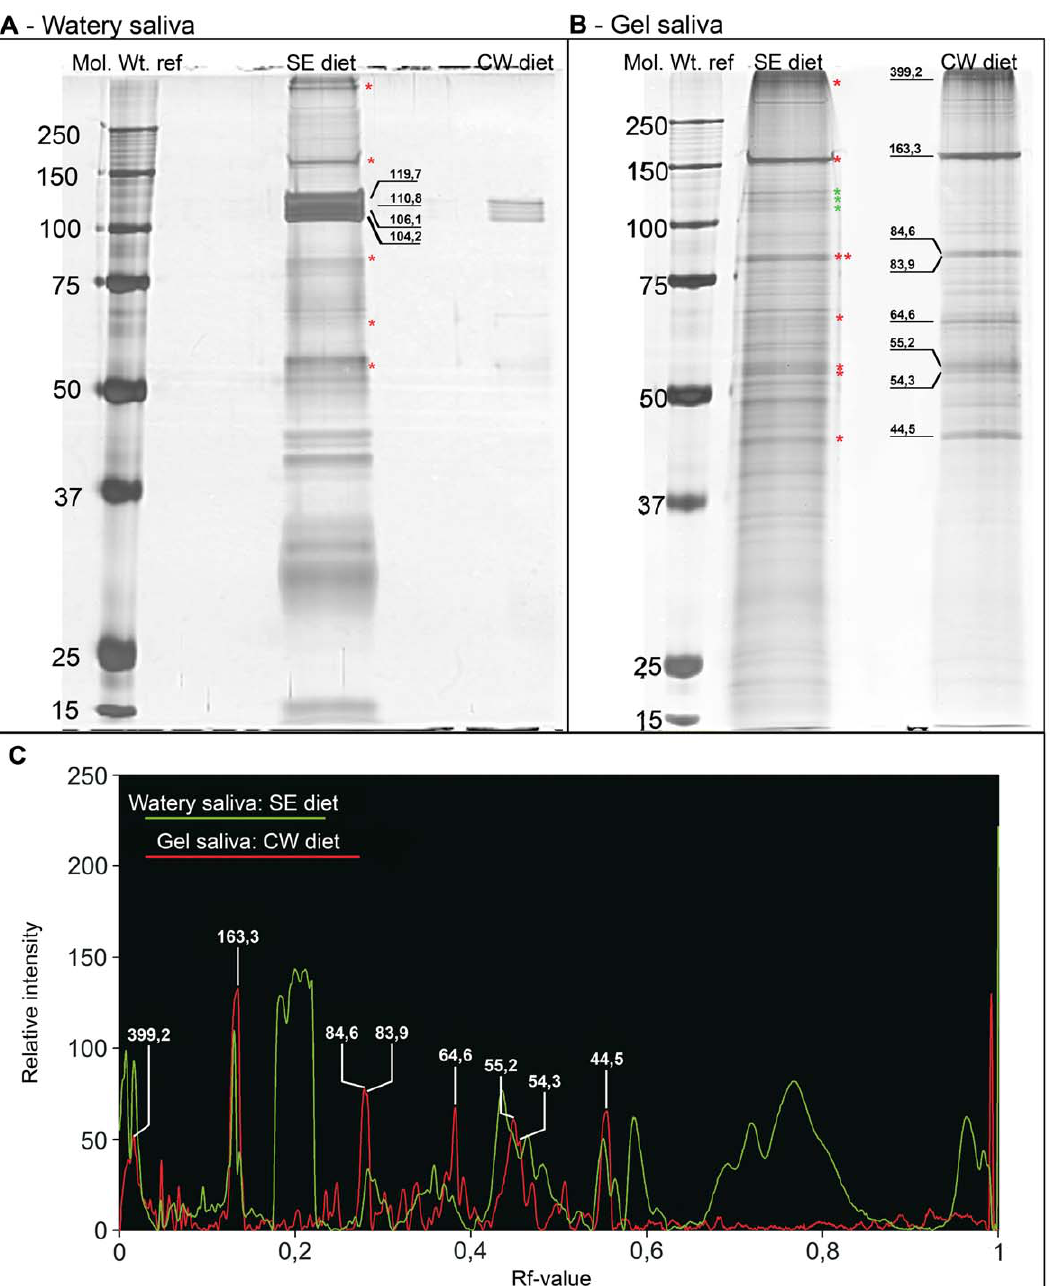
Figure 4. Separation and comparison of saliva protein fractions from M.viciae collected in SE – and CW-diet. Soluble and non-soluble protein fraction of saliva concentrate collected from SE-diet and CW-diet were separated in a 10% separation gel. Gels were silver stained. Lane 1 of each gel contains marker proteins Molecular weights (kDa) are given on the left. A ) The soluble fraction from SE-diet shows 45 protein bands while in samples from CW-diet only 6 protein bands are detected. All latter protein bands match bands from the SE-diet but have a much lower abundance. B ) Non-soluble fraction samples have fewer protein bands in CW-diet (lane 3, n=66) than in SE-diet (lane 2, n=87). Matching bands of lanes 2 and 3 show comparable intensities. The most intense protein bands (MWs are given in B ) of the non-soluble fraction from CW-diet are used as reference proteins for this saliva fraction and are labeled with their MWs. Protein bands with corresponding MW in other lanes are marked with red asterisks. Protein bands of insoluble fraction that correspond to soluble fraction from SE-diet ( A ) are labeled with green asterisks and MWs are given in A . C ) To discriminate protein bands of non-soluble fraction (red graph) from those of soluble fraction (green graph), soluble fraction from SE-diet ( A , lane 2) was compared with non-soluble fraction from CW-diet ( B , lane 3). The relative pixel intensity value (arbitrary units) is plotted against the retardation factor (Rf-value). Most intense proteins from non-soluble fraction (MWs are given), all of which have a relative pixel intensity . 50, show a coincidence with 6 protein bands in the soluble fraction collected from SE-diet (red asterisks). Specific proteins from soluble fraction with a relative intensity of more than 50 (RF-value of approx. 0.2 (MWs in A and green asterisks in B ) and higher 0.57), are only slightly visible in non-soluble fraction from CW- diet ( C ).